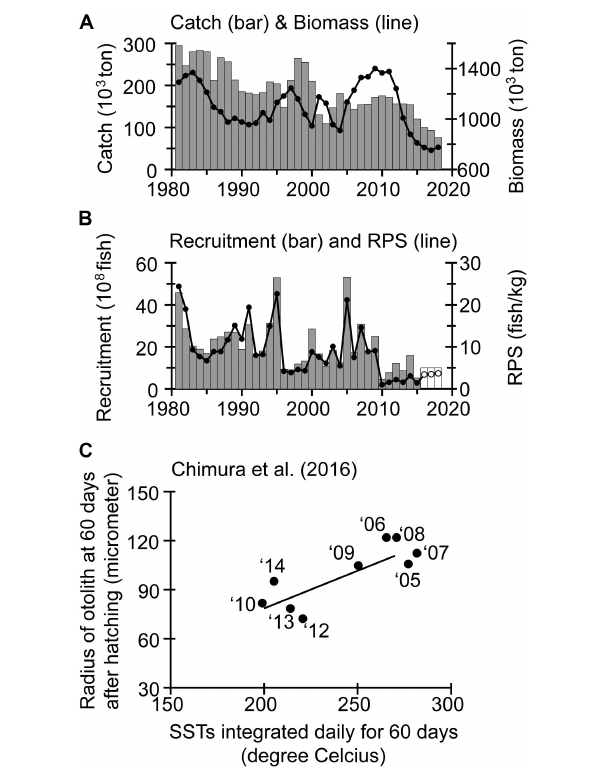
FIGURE 7 | (A) Catch (bar chart), biomass (line graph), (B) recruitment (bar chart), and recruitment per spawning stock biomass (RPS) (line graph) for the Japanese Pacific stock (JPS) of walleye pollock. Open bars and circles in (B) indicate provisional values. (C) Relationship between SSTs integrated daily for 60 days in Funka Bay and otolith radius of walleye pollock larvae 60 days after hatching, averaged for each year class. The larvae were sampled from Funka Bay in April of 2005–2014. Panel (C) was digitized from Chimura et al. (2016).